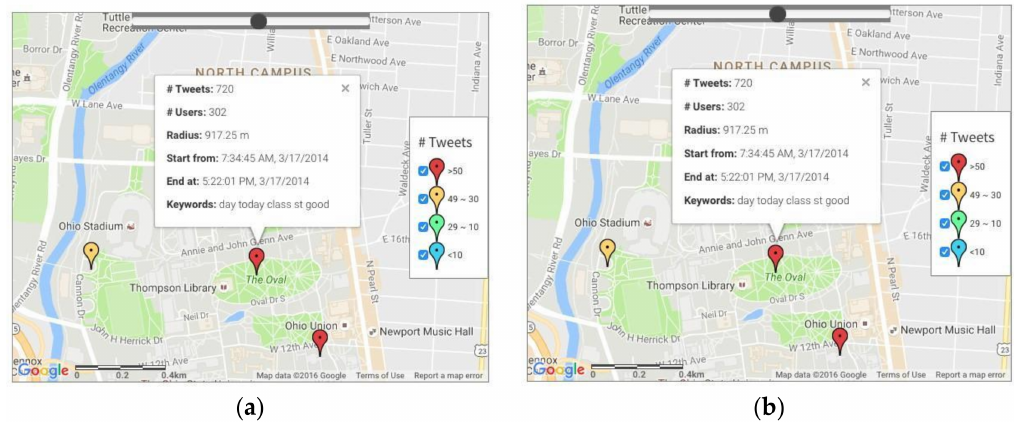
Figure 6. Spatial-temporal clustering results for tweets on Saint Patrick’s Day, 17 March 2014 in Columbus OH: ( a ) cluster centers and the most significant cluster; and ( b ) distribution of the tweets in the most significant cluster.